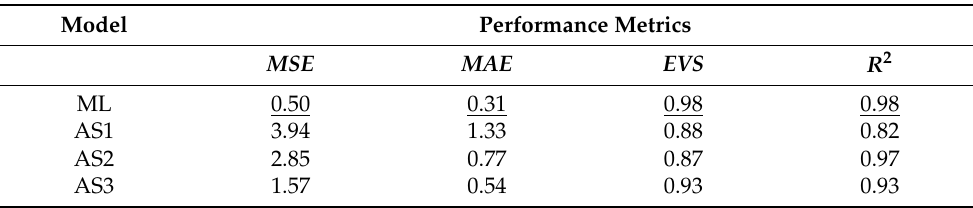
Table 3. Statistical performance metrics of different penetration depth models. Model